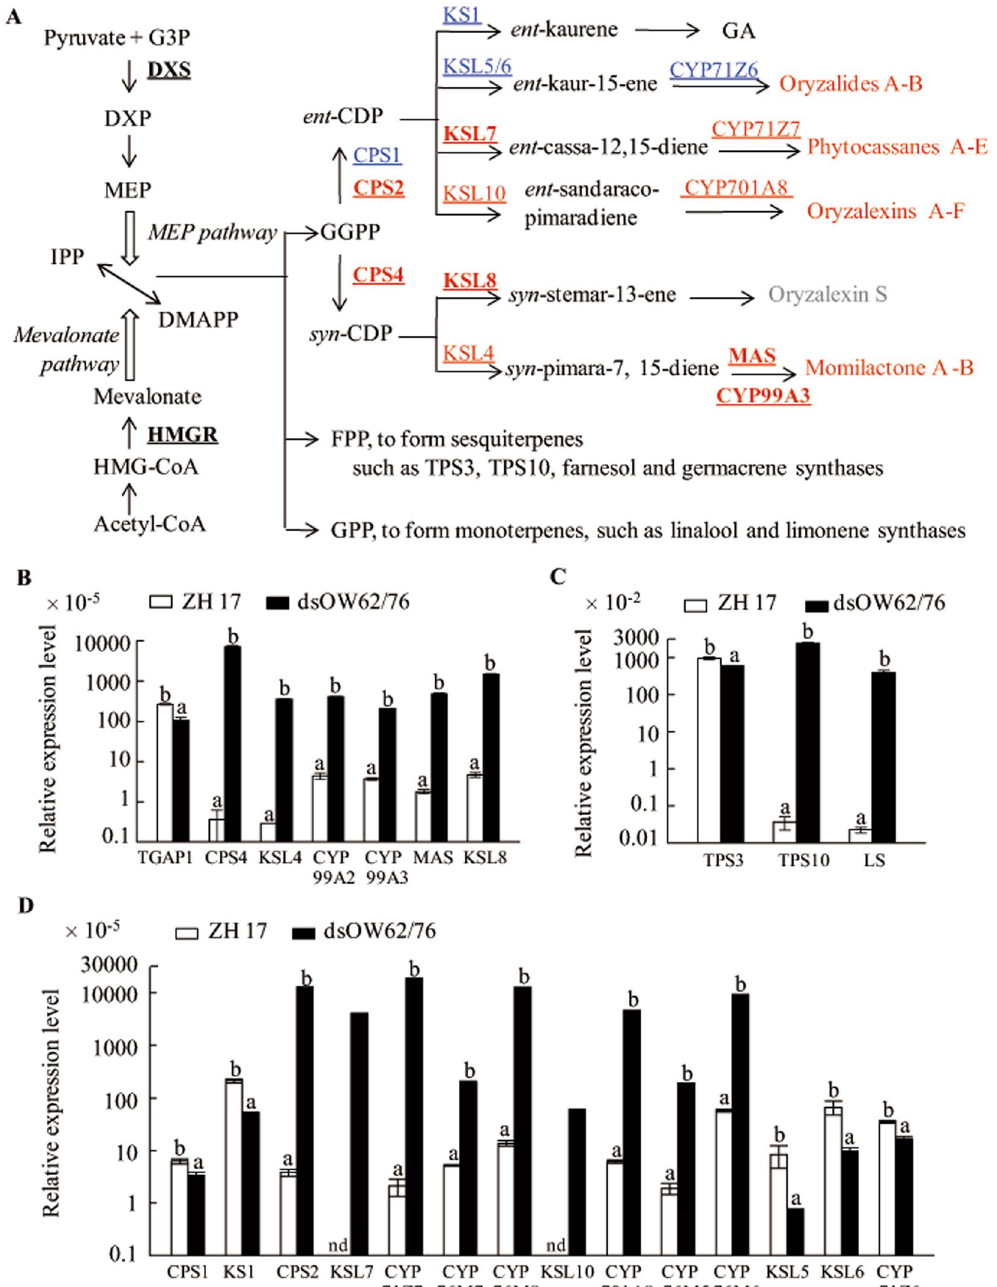
Figure 5. Schematic overview of the changes in terpenoid biosynthesis pathways ( A ) and analysis of the related gene expression ( B – D ) in dsOW62/76 and ZH17 plants. ( A ) The cytosolic mevalonate and the plastidial MEP pathways generated IPP and DMAPP are used to produce terpenoids. The font colors and shapes represent the same meanings as described in Fig. 1. ( B ) Expression of the gene cluster related to diterpenoid phytoalexin biosynthesis on chromosome 4, TGAP1 and KSL8 genes. ( C ) Expression of terpene synthase genes. ( D ) Expression of the gene cluster related to diterpenoid phytoalexin biosynthesis on chromosome 2, CPS1 , KS1 , and KSL10 genes. Data are means ± SE of three replicates. A rice ubiquitin gene was used as the internal standard for qPCR analysis. Values marked with different letters indicate statistically significant differences as analyzed by SAS software (Duncan’s multiple range test, α = 0.05). nd for not detected. Abbreviations: CDP, copalyl diphosphate; DMAPP, dimethylallyl diphosphate; DXP, 1-deoxy-D-xylulose 5-phosphate; FPP, farnesyl diphosphate; GA, gibberellin; GGPP, geranylgeranyl diphosphate; GPP, geranyl diphosphate; HMG-CoA, 3-hydroxy-3-methylglutaryl-CoA; IPP, isopentenyl diphosphate; MEP, 2- C -methyl- D -erythritol-4-phosphate; CPS, copalyl diphosphate synthase; DXS, DXP synthase; HMGR, 3-hydroxy-3-methylglutaryl-CoA reductase; KS, kaurene synthase; KSL, KS like; LS, linalool synthase; MAS, a dehydrogenase; TPS, terpene